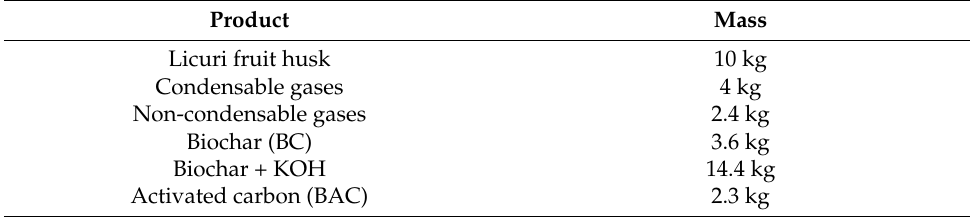
Table 8. Performance of the BAC production